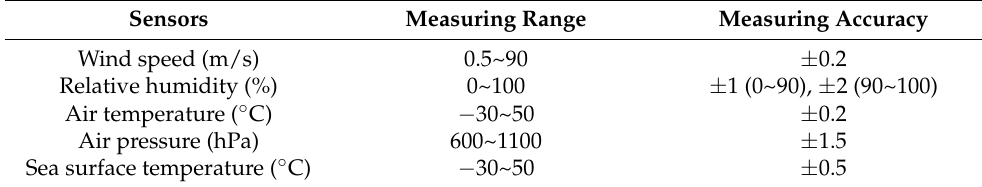
Table 1. Parameters of all sensors.